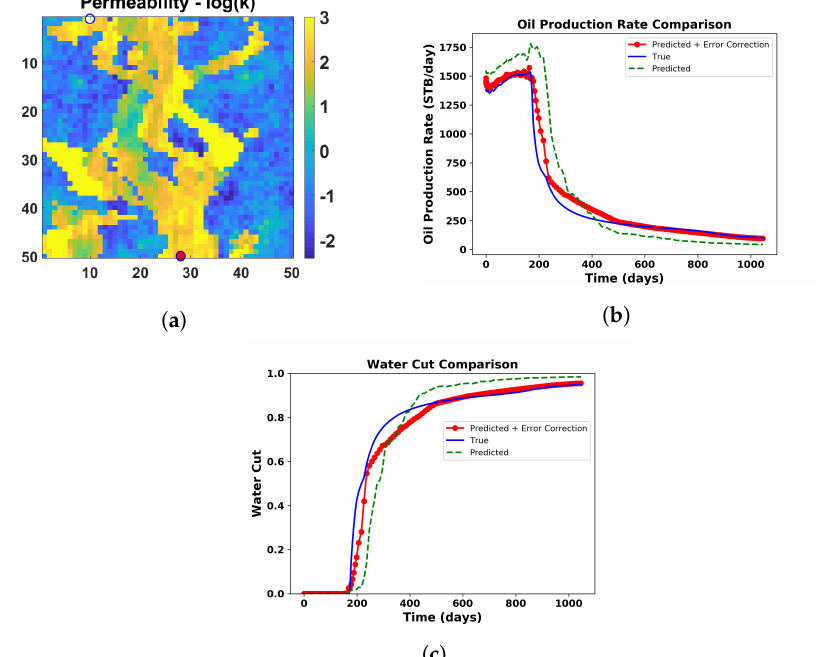
Figure 41. ( a ) Test case 2 with the producer well location at (28,50). ( b ) Comparison of the oil production rate and ( c ) comparison of water cut, predicted using the global PMOR method alone (dotted green line) and after the implementation of error correction model (red circled line) with the true solution (blue